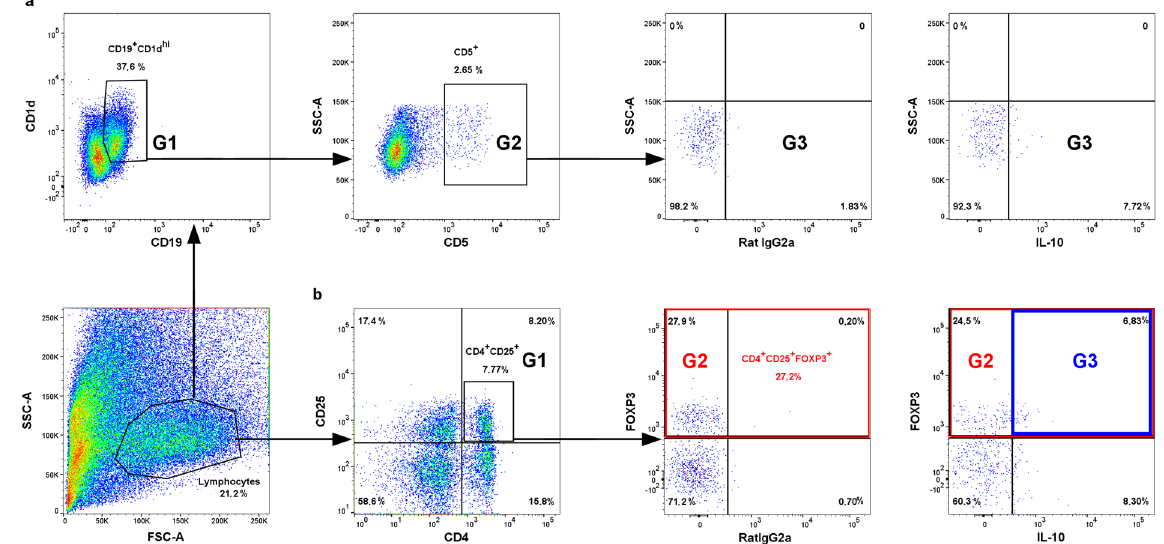
Figure 2. Representative dot plots for the process of regulatory T and B lymphocytes gating in spleen sample. (a) Gating strategy for CD19 + CD1d + CD5 + IL-10 + lymphocytes: G1 represents CD19 + CD1d + cells, G2 represents CD19 + CD1d + CD5 + cells, and G3 represents CD19 + CD1d + CD5 + IL-10 + cells. (b) Gating strategy for CD4 + CD25 + FOXP3 + IL-10 + lymphocytes: G1 represents CD4 + CD25 + cells, G2 represents overall CD4 + CD25 + FOXP3 + cells, and G3 represents CD4 + CD25 + FOXP3 + IL-10 +